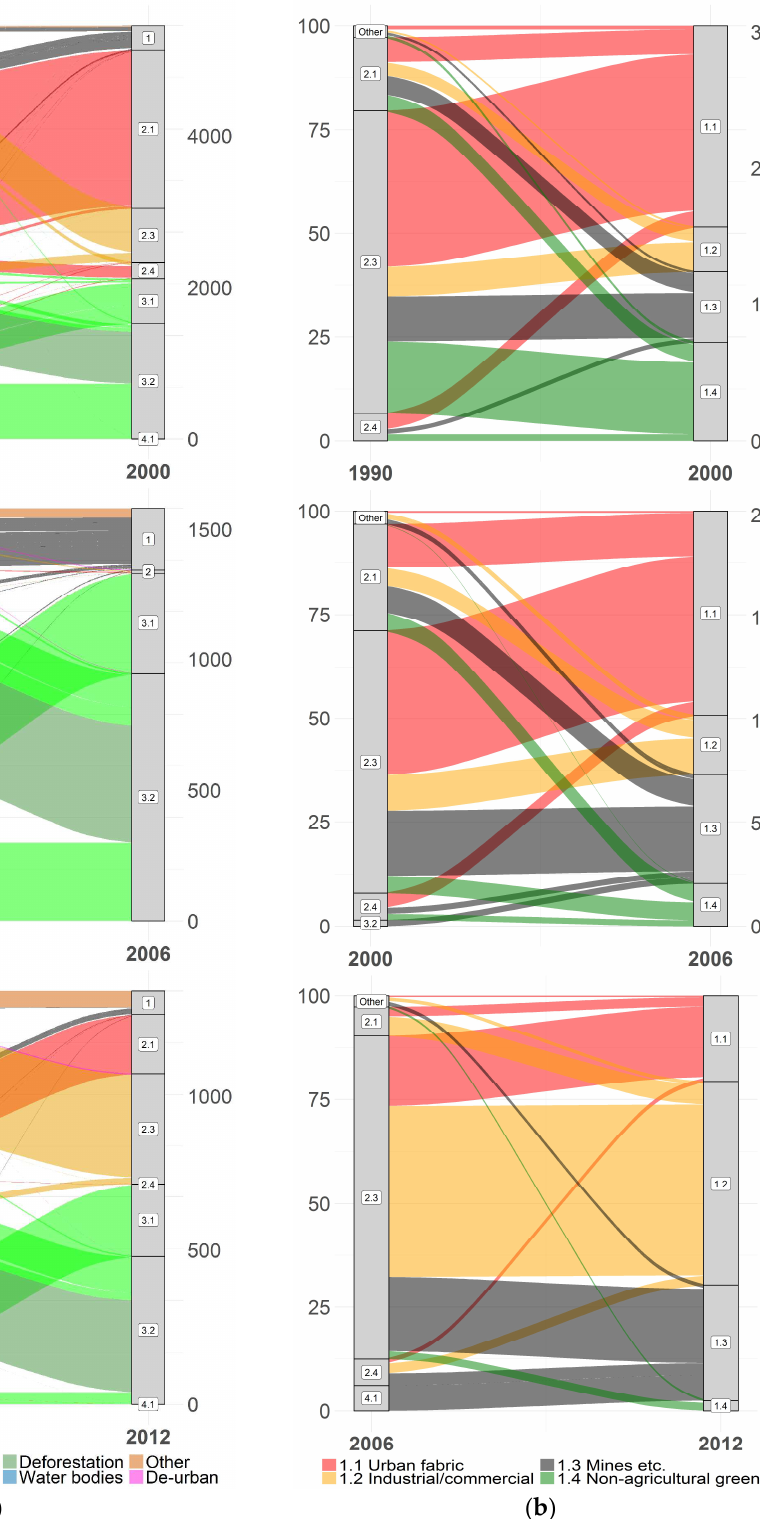
Figure 3. Land use flows in Ireland over 1990–2012. Left scale is in per cent of total land cover flows and right scale is in 000 km 2 . Sub-figure ( a ) shows all land cover flows (LCF); sub-figure ( b ) displays land changes leading to the creation of artificial